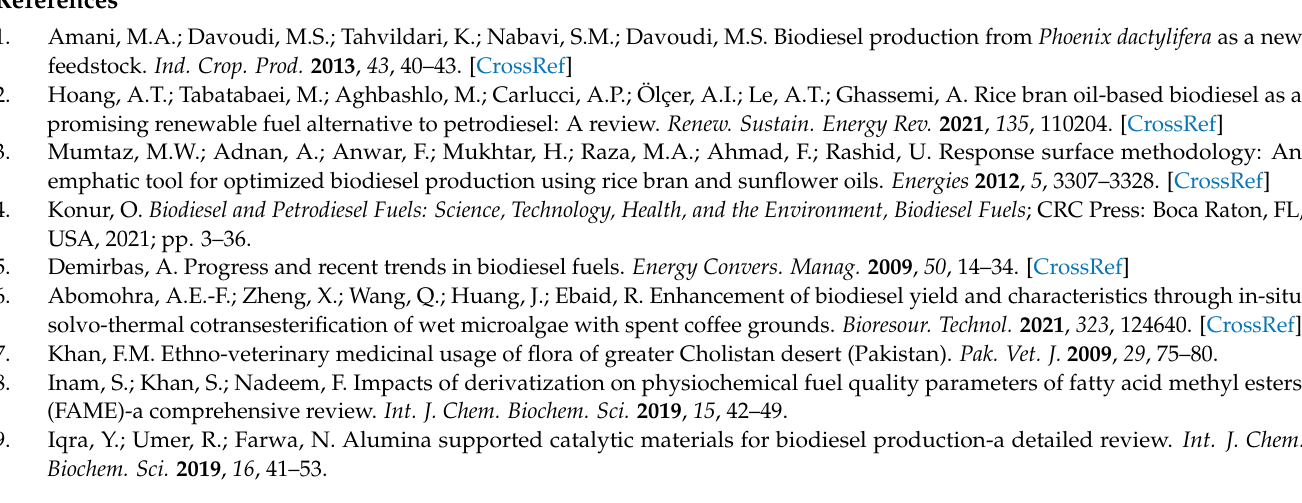
Table 3. Iodine value (g I 2 /100 g) of biodiesel from sunflower, mustard, and pearl millet seed